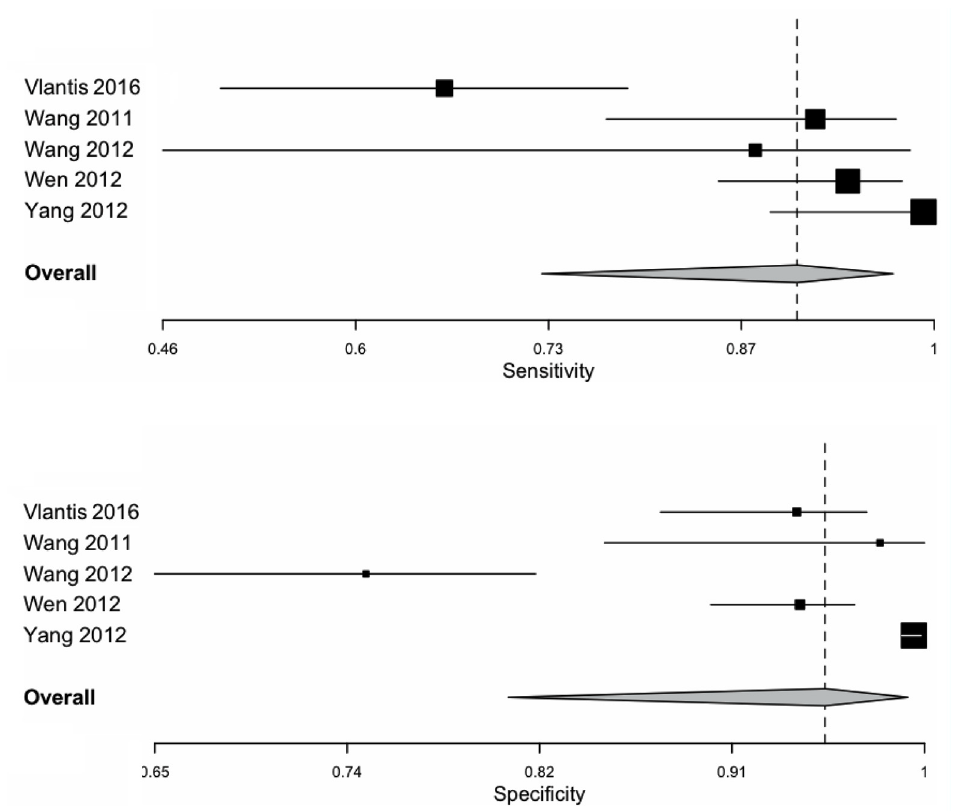
Figure 2. Narrow-band imaging sensitivity and specificity forest plots summarized the individual as well as the pooled sensitivities and specificities for nasendoscopy with narrow band imaging settings.